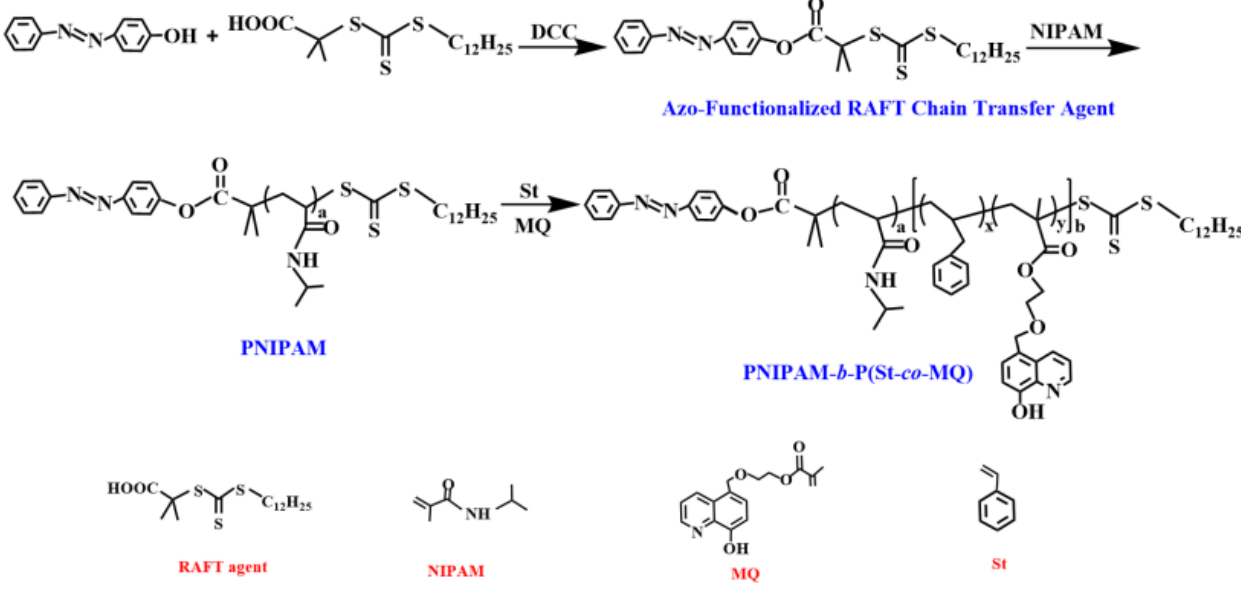
Figure 1. Schematic illustration for preparation of PNIPAM- b -(St- co -MQ).